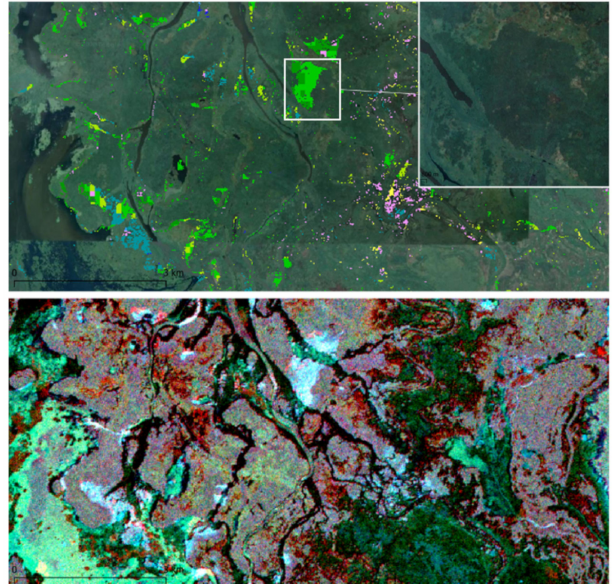
Figure 14. Detail area ( b ) in Figure 10. Top: pixels corresponding to clusters 4 and 5, colored according to the underlying CORINE class; inset shows a detail area (see text for explanation); background from Google Earth TM imagery. Bottom: same area, extracted from the RGB change image in Figure